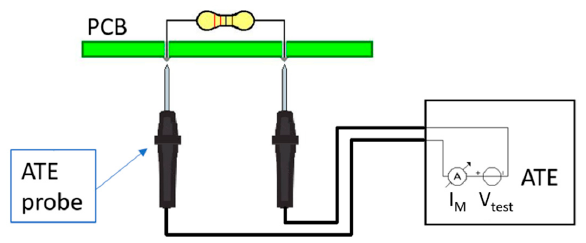
Figure 1. In-circuit test approach.